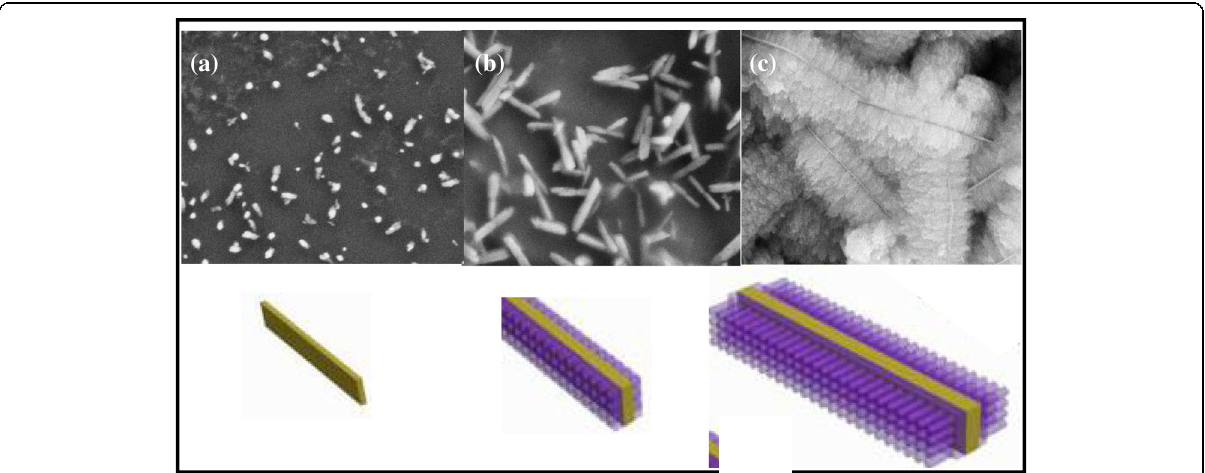
Fig. 4 The schematic diagram of formation processes for ZnO hierarchical structures: a the trunk formation of ZnO nano-sheets; b secondary heterogeneous nucleation and growth of branches; c the continuously growth of primary nano-sheets and secondary nano-branches constructs the feather-like ZnO hierarchical structures